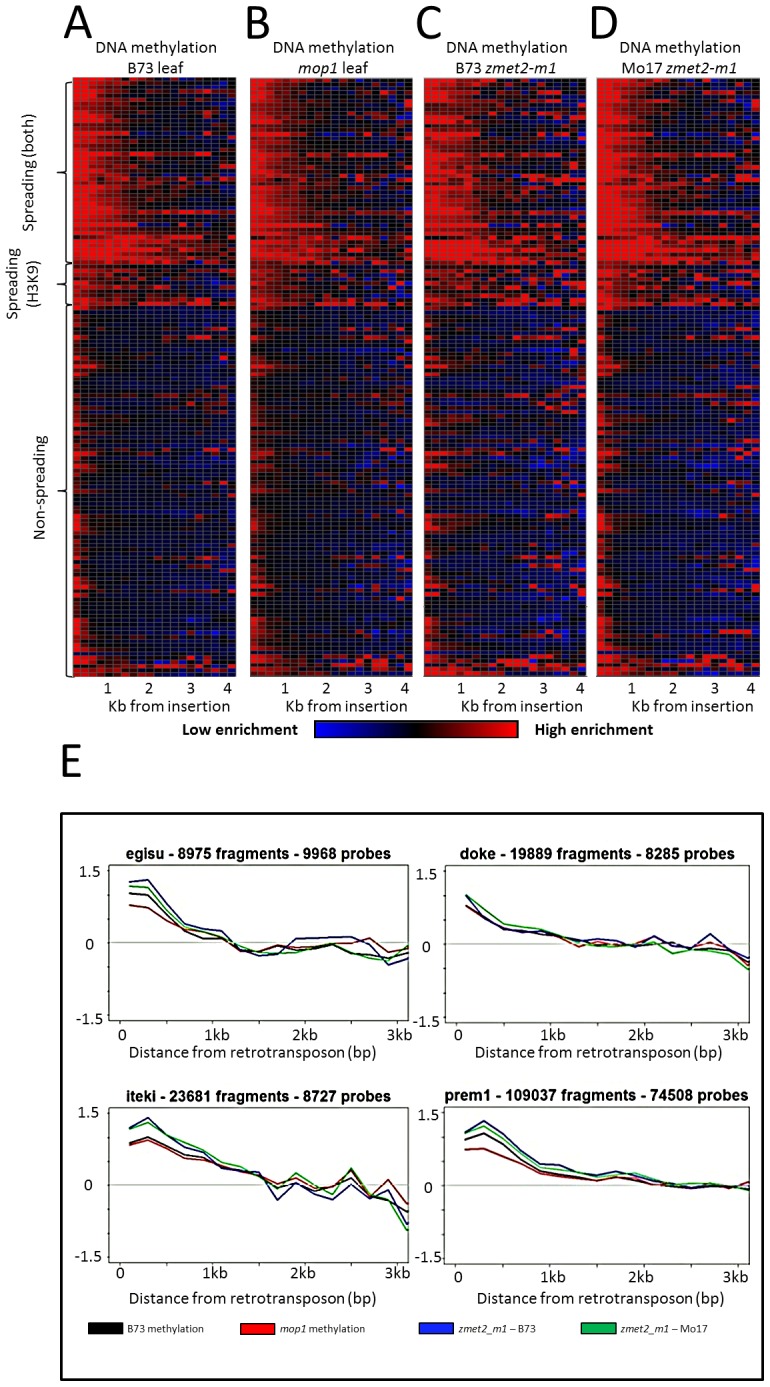
DNA methylation enrichment near retrotransposons is not affected by mop1 or zmet2-m1 mutations.The relative level of DNA methylation in each 200 bp bin is shown for each of the 144 retrotransposon families. Modification levels calculated include probes flanking both ends of retrotransposns. The red color indicates enrichment for the modification while blue indicates depletion of the mark. Black indicates levels of the modification similar to genome-wide average values. The retrotransposons are grouped according to whether they show spreading for DNA methylation and H3K9me2, just H3K9me2 or neither of the marks. The profiles are shown for B73 leaf (A), homozygous mop1 mutant (B), homozygous mutant zmet2-m1 in B73 (C) and Mo17 (D) genetic backgrounds. Example plots of methylation levels in the same backgrounds (E) indicate minimal differences between mutant backgrounds on spreading.